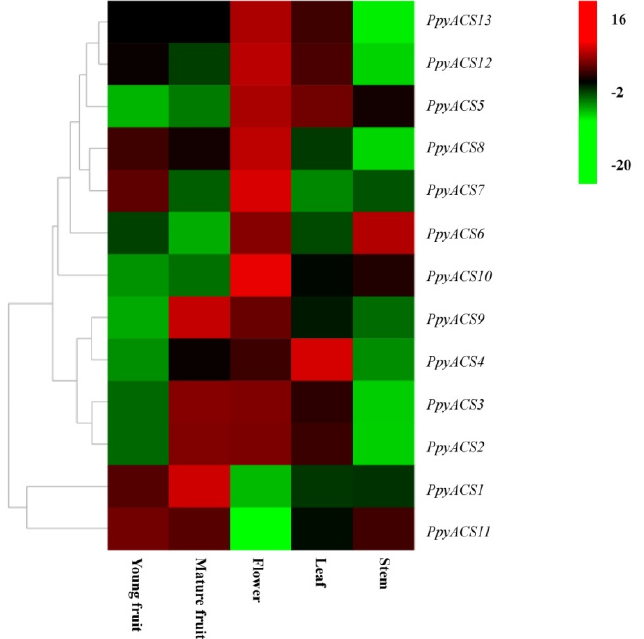
Figure 5. Heat map of the expression level of PpyACSs in different organs. The tissues used for the expression profiling are indicated at the bottom of each column. A cluster dendrogram is shown on the left. ACSs are divided into 3 major groups based on their expression. The color key at the top right corner represents the Z-score values transformed from log2-based expression values obtained by qRT-PCR.